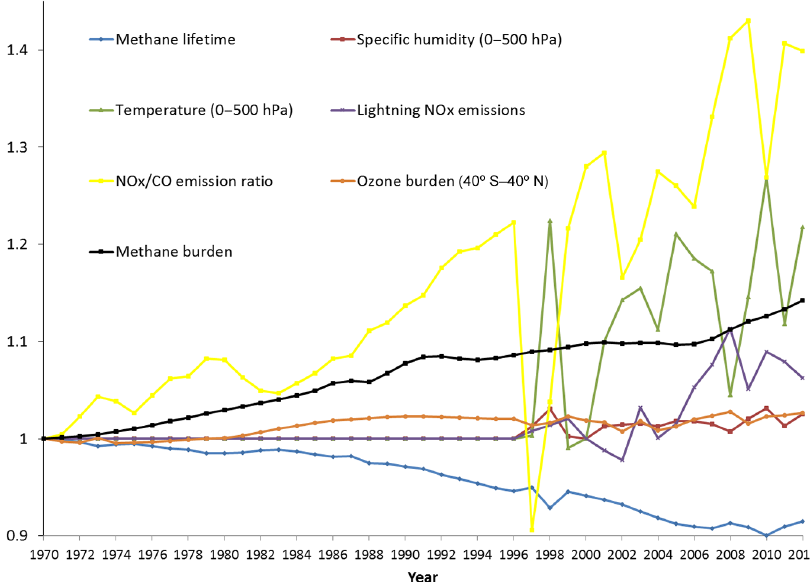
Figure 16. Development in atmospheric CH 4 lifetime and key parameters known to influence CH 4 lifetime. All variables values are relative to 1970. (To make it apparent in the figure, temperature variations are relative to the Celsius